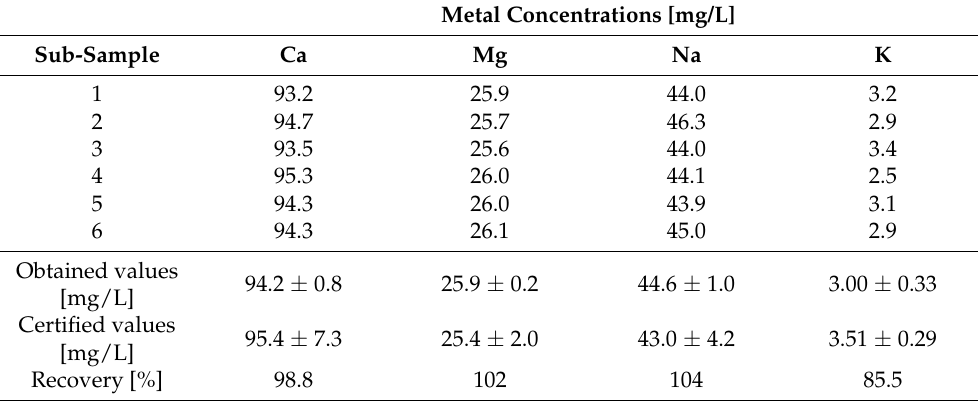
Table A1. Detailed results of the RM analysis (n = 6).